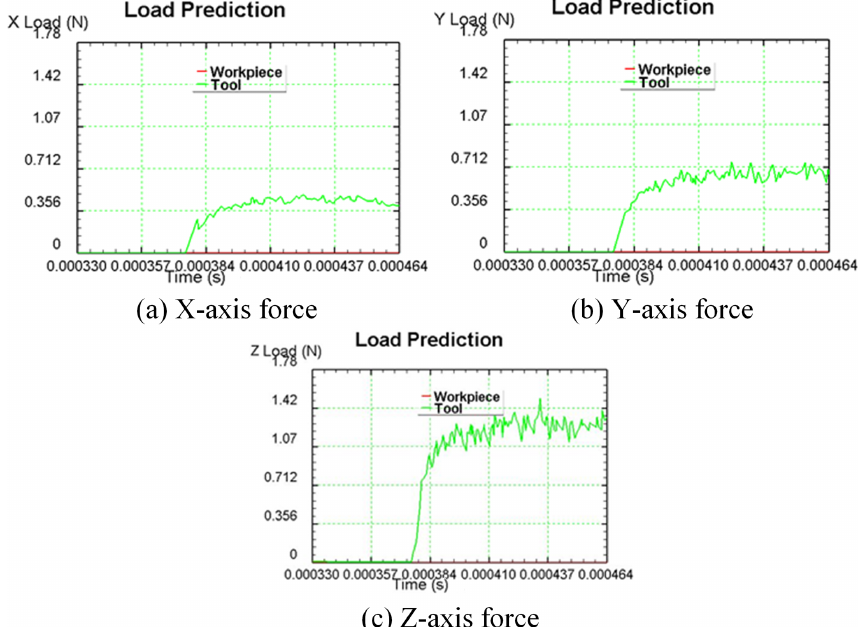
Figure 5. Simulated milling forces of end cutting